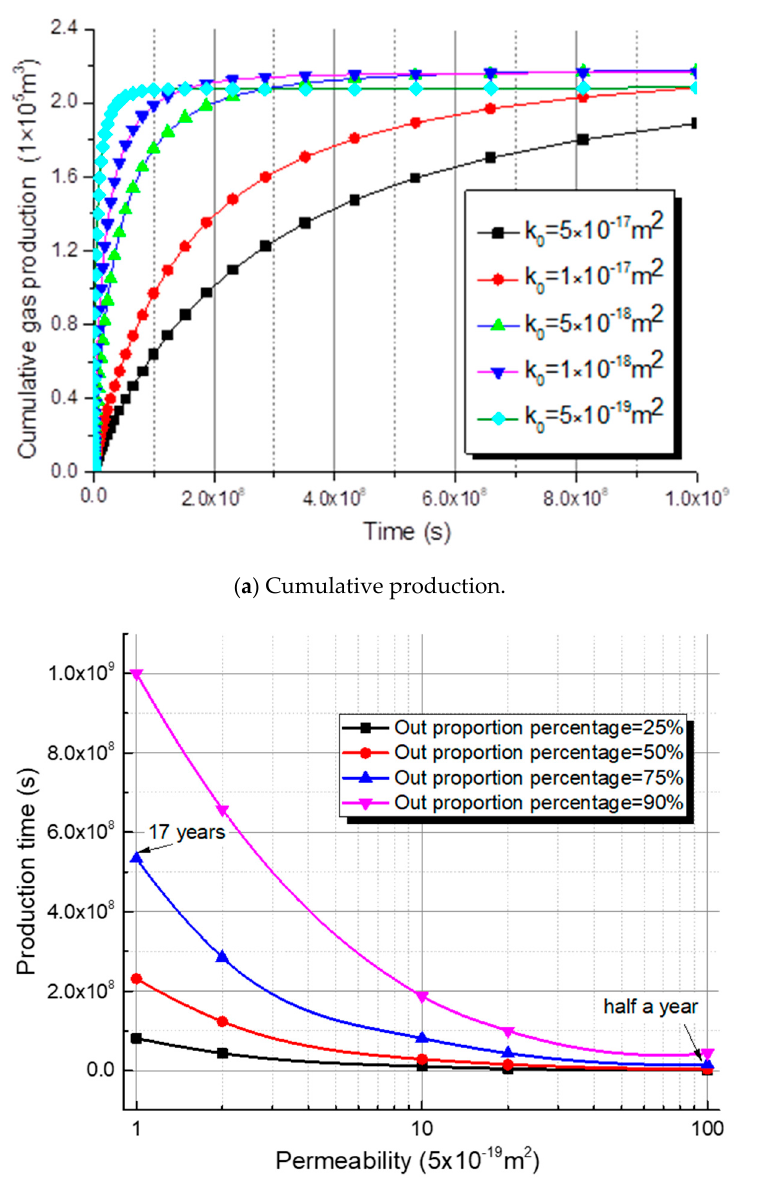
Figure 10. Gas production with different initial reservoir permeability.